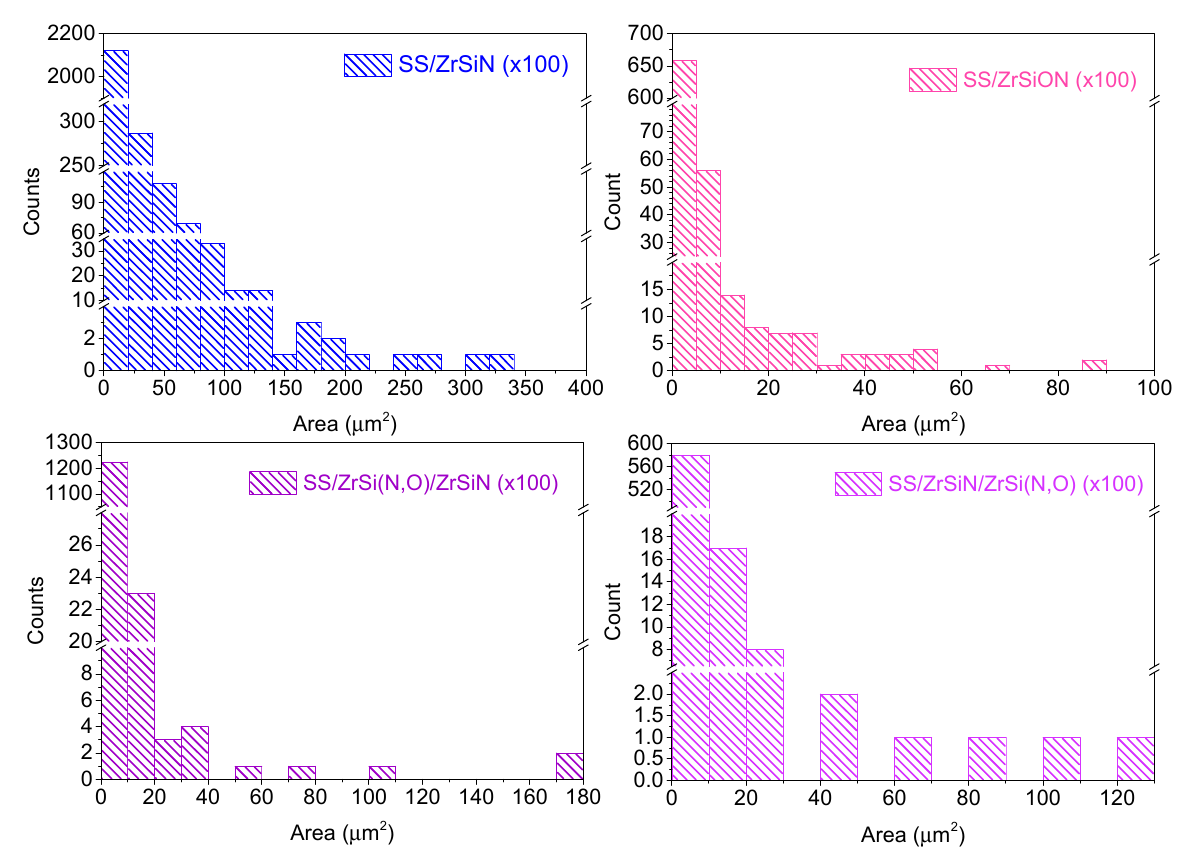
Figure 2. The size distribution of the microdroplets on the surface of each deposited coating, derived from the binary images using the ImageJ software.